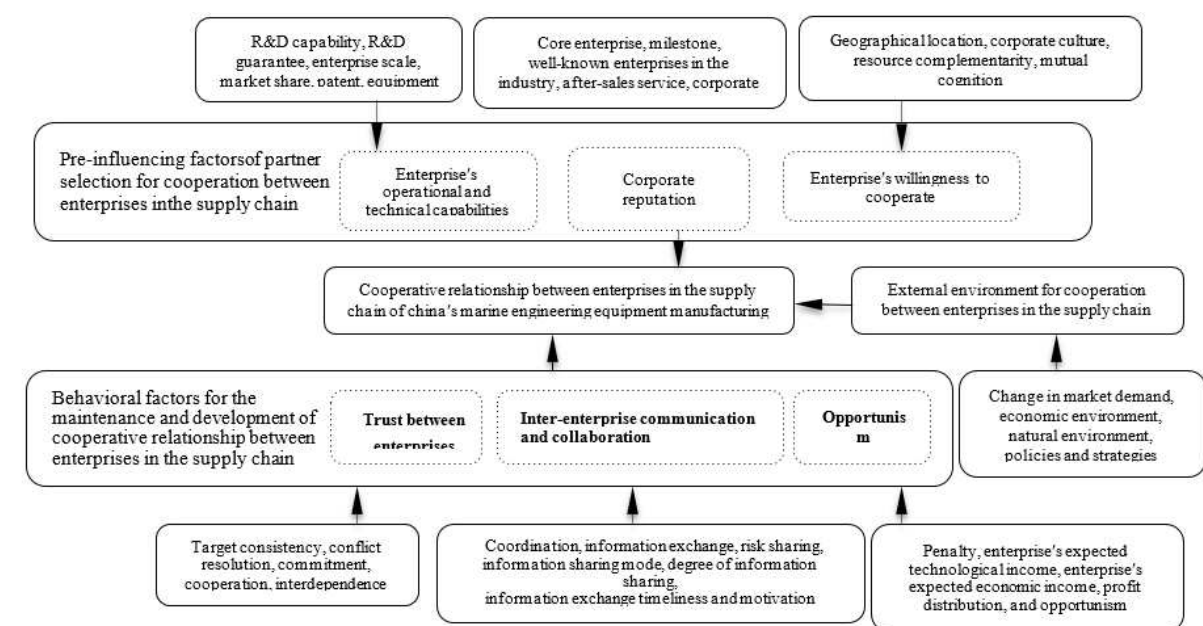
Fig. 2 Conceptual model of the factors influencing the cooperative relationship between enterprises in the supply chain